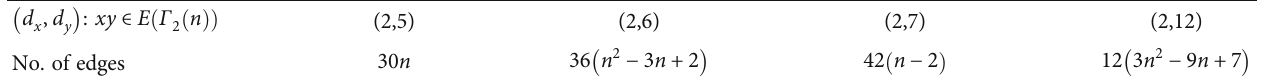
n Þ with respect to degree of end vertices. 2 ð